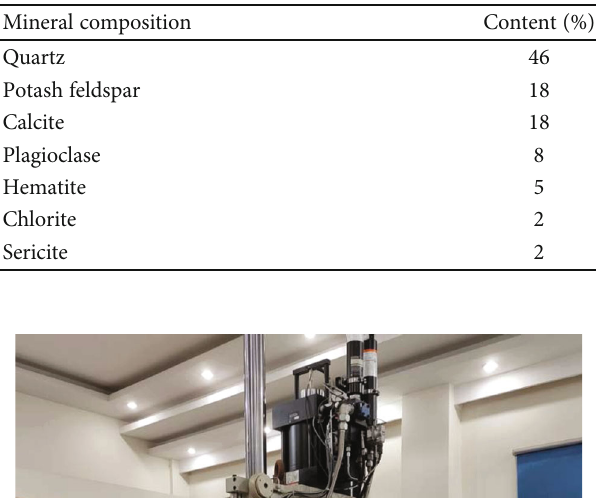
Figure 1: Optical microscopy analysis of the sandstone. Table 1: Mineral composition of sandstone specimen.